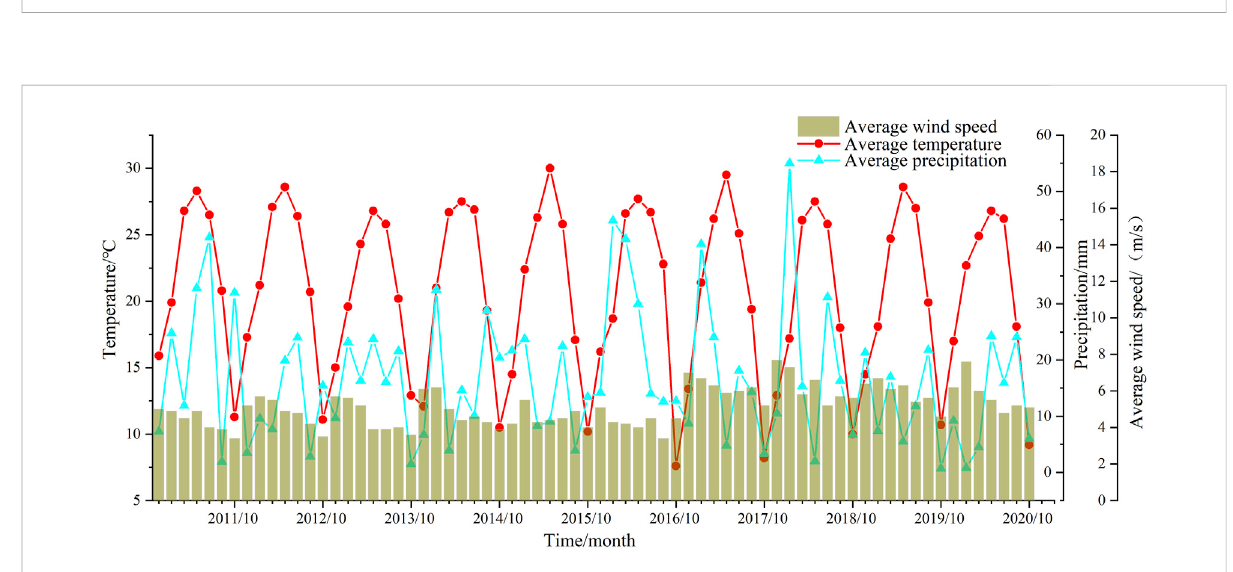
FIGURE 4 Temperature and wind speed results for Alashankou meteorological